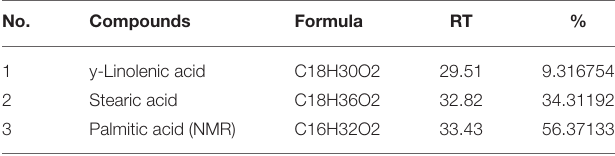
TABLE 5 | Major compounds identified in barley bran n -hexane extract using the LC-MS method.